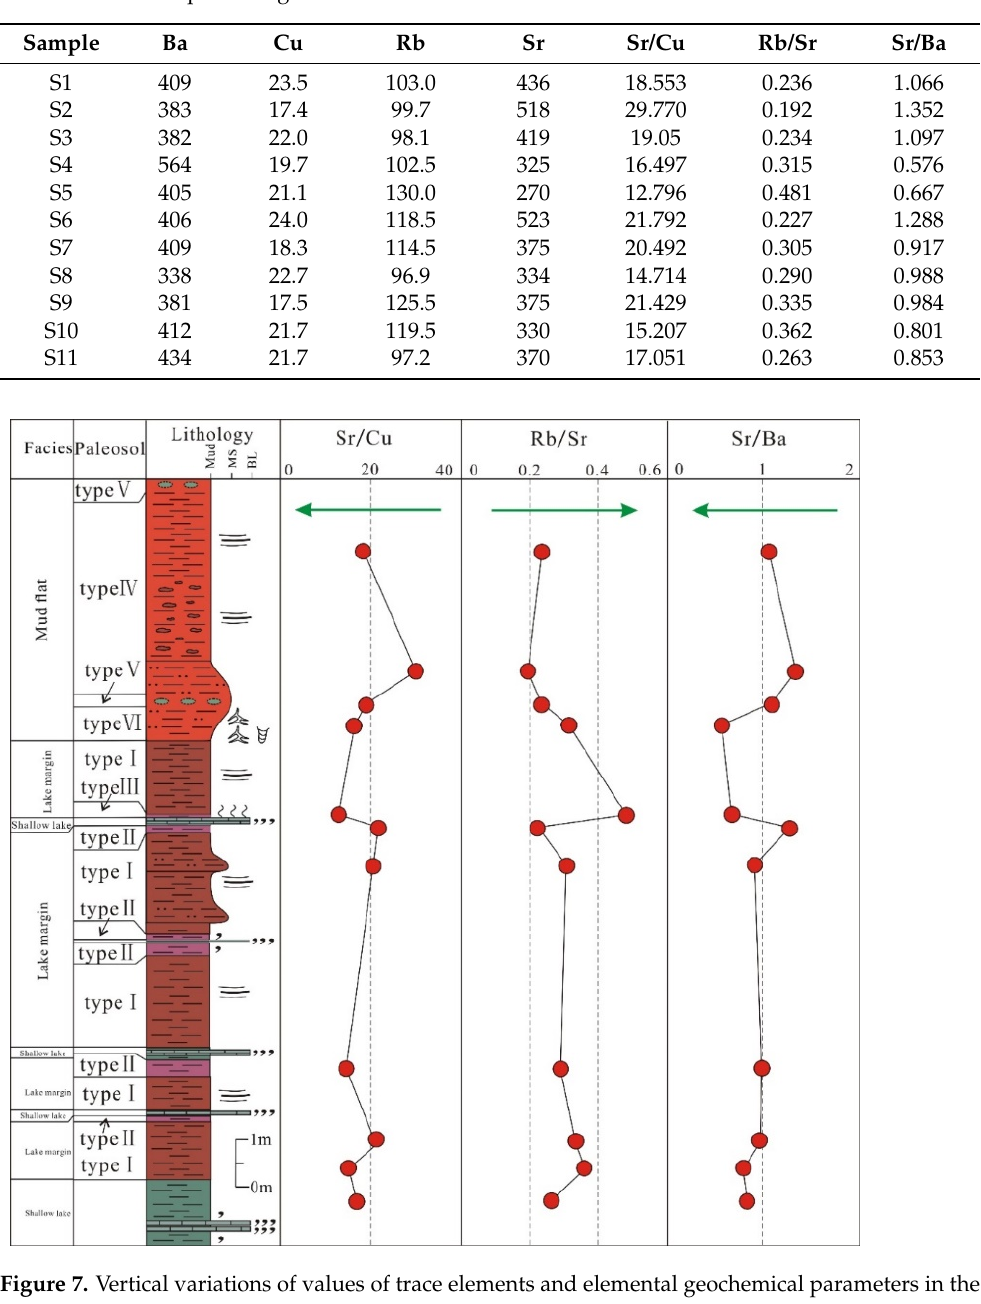
Table 2. The concentration of trace elements (ppm) and associated geochemical parameters. See the location of the samples in Figure 2A.